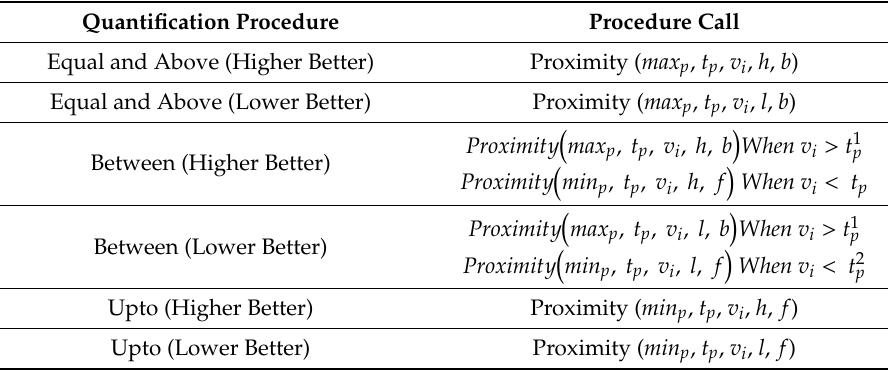
Table 5. Proximity based formulas.